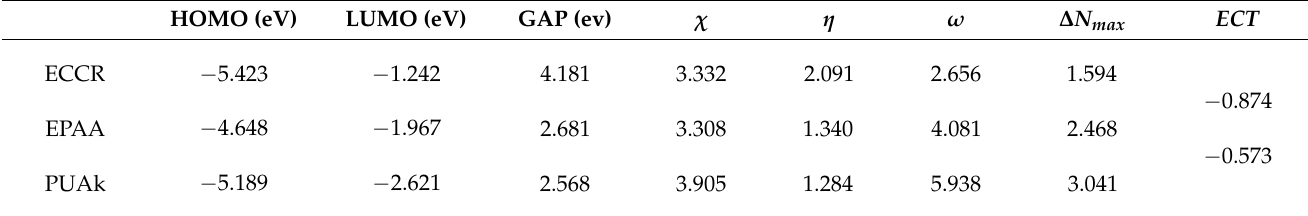
Table 7. Global reactivity